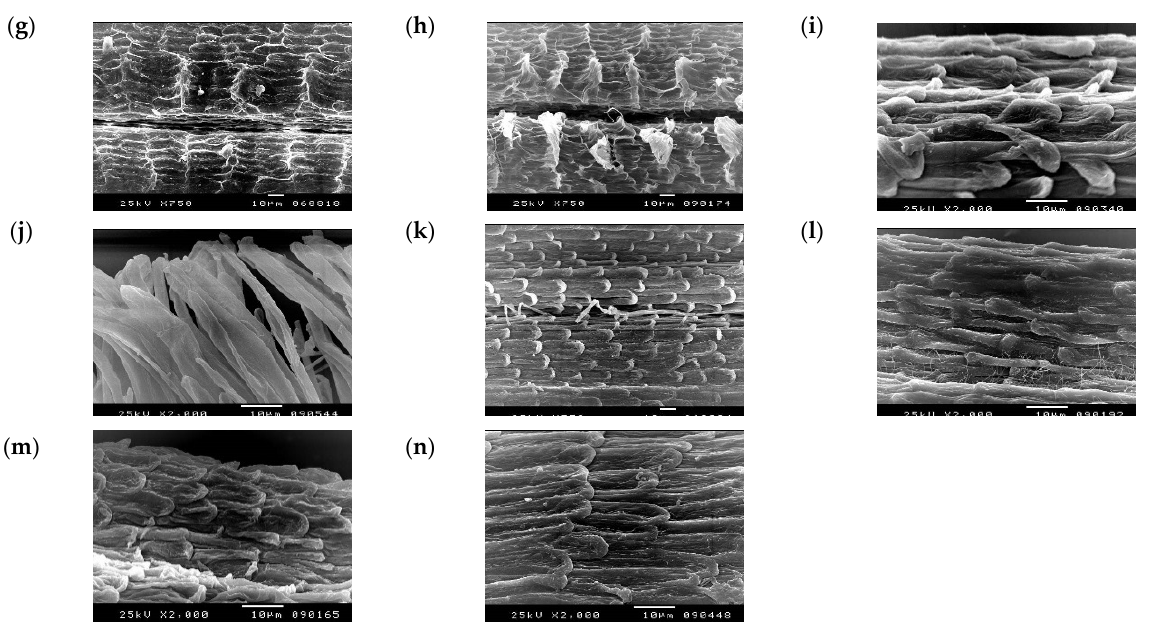
Figure 6. SEM micrographs of inner achenes. Epidermal Cell (EC), End Wall (EW), Anticlinal Wall (AW), Relief of Cell Boundary (RCB), Outer Periclinal Wall (OPW) and Fine Relief of Periclinal Wall (FRPW). ( a ) Reichardia tingitana , isodiametric EC, obscure EW, AW and RCB, sparsely tuberculate OPW, nearly smooth FRPW. ( b – n ) Launaea : ( b , c ) L. spinosa , elongated nearly adjusted EC, long antrorse projection of EW, raised straight AW, channelled RCB, concave OPW, nearly smooth FRPW; ( d ) L. capitata , isodiametric EC, EW without projection (at the achene wing), raised straight to irregular AW, raised RCB, concave OPW, nearly smooth FRPW; ( e ) L. intybacea , elongated adjusted EC, short antrorse projection of EW, raised straight AW, channelled RCB, concave OPW, nearly smooth FRPW; ( f ) L. massauensis , elongated nearly adjusted EC, EW without projection, raised straight AW, raised RCB, concave OPW, nearly smooth FRPW; ( g , h ) L. nudicaulis : EW without projection, raised straight AW, raised RCB, concave OPW, nearly smooth FRPW, ( g ) group 6, elongated adjusted EC, ( h ) group 7, elongated nearly adjusted EC; ( i ) L. angustifolia subsp. angustifolia , diffused EC, long antrorse projection of EW, raised straight AW, channelled RCB, flat OPW, striate FRPW; ( j ) L. angustifolia subsp. arabica , obscure EC, EW, AW and RCB, nearly smooth FRPW, papillose OPW; ( k , l ) L. fragilis subsp. fragilis , ( k ) nearly adjusted EC, long antrorse projection of EW, raised straight AW, channelled RCB, flat OPW, nearly smooth FRPW; ( l ) diffused EC, short antrorse projection of EW, raised straight AW, raised RCB, concave OPW, striate FRPW; ( m , n ) L. mucronata : elongated adjusted EC, raised straight AW, channelled RCB, flat OPW, striate FRPW, ( m ) subsp. cassiniana , long antrorse projection of EW, ( n ) subsp. mucronata , short antrorse projection of EW.